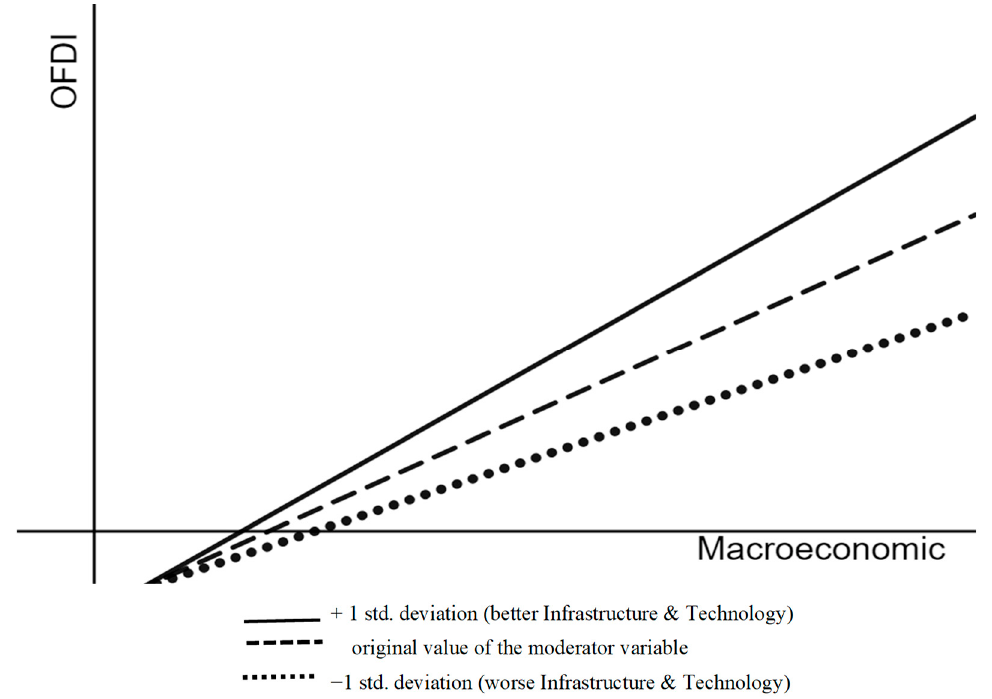
Figure 4. The positive moderating effects of infrastructure and technology on the macroeconomic performance and OFDI intensity relationship in